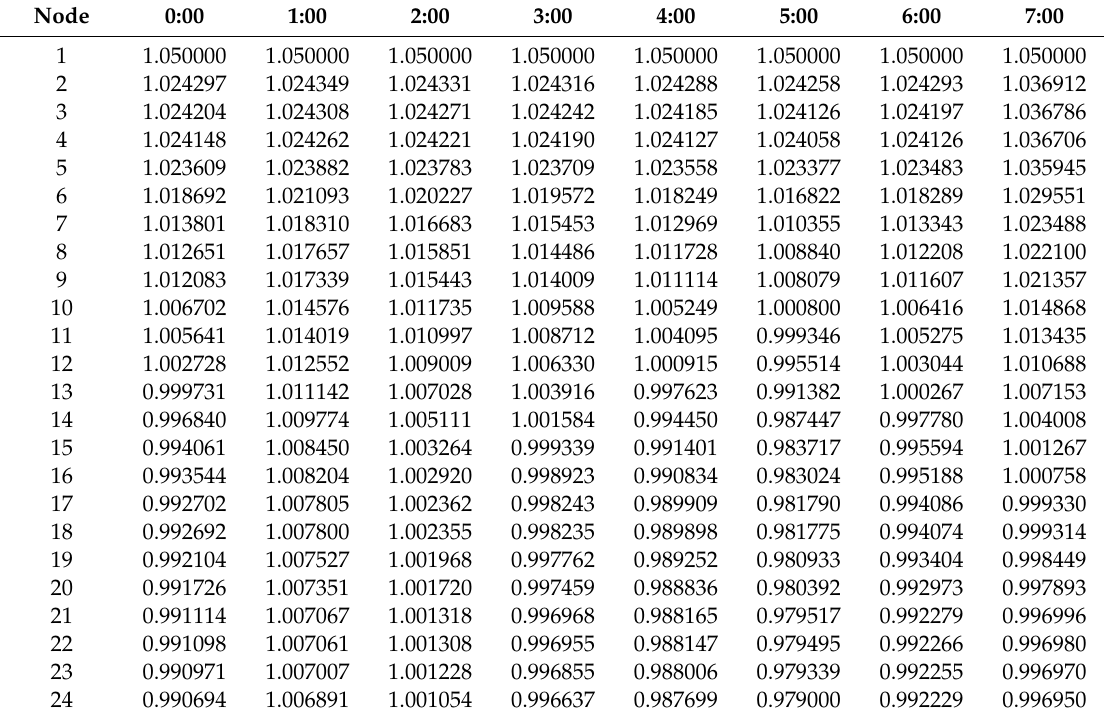
Table A2. Voltage results obtained by S1 of Case 1